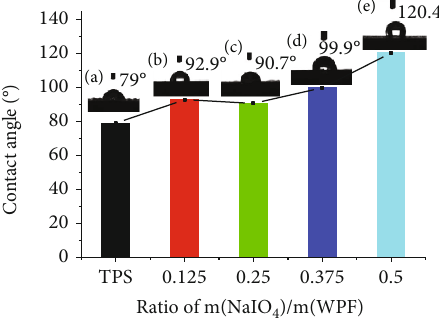
Figure 8: Contact angle of TPS and OWPF/TPS composites: (a) TPS; (b) 0.125 OWPF/TPS; (c) 0.25 OWPF/TPS; (d) 0.375 OWPF/TPS; and (e) 0.5